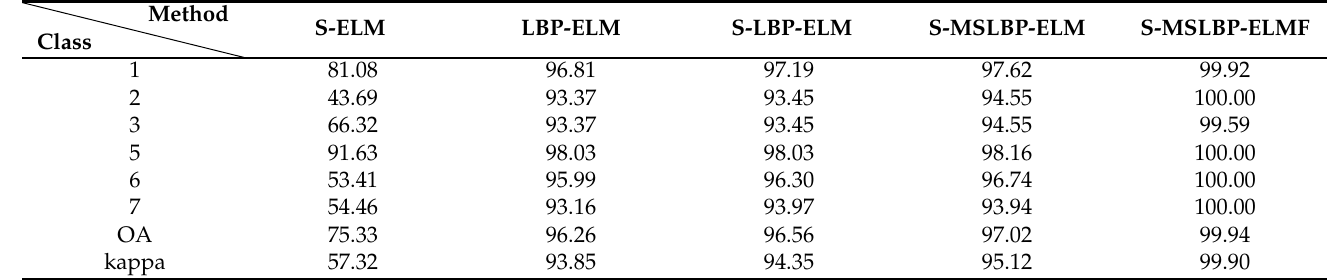
Table 4. Interpretation accuracies of different methods on saline areas dataset (%).